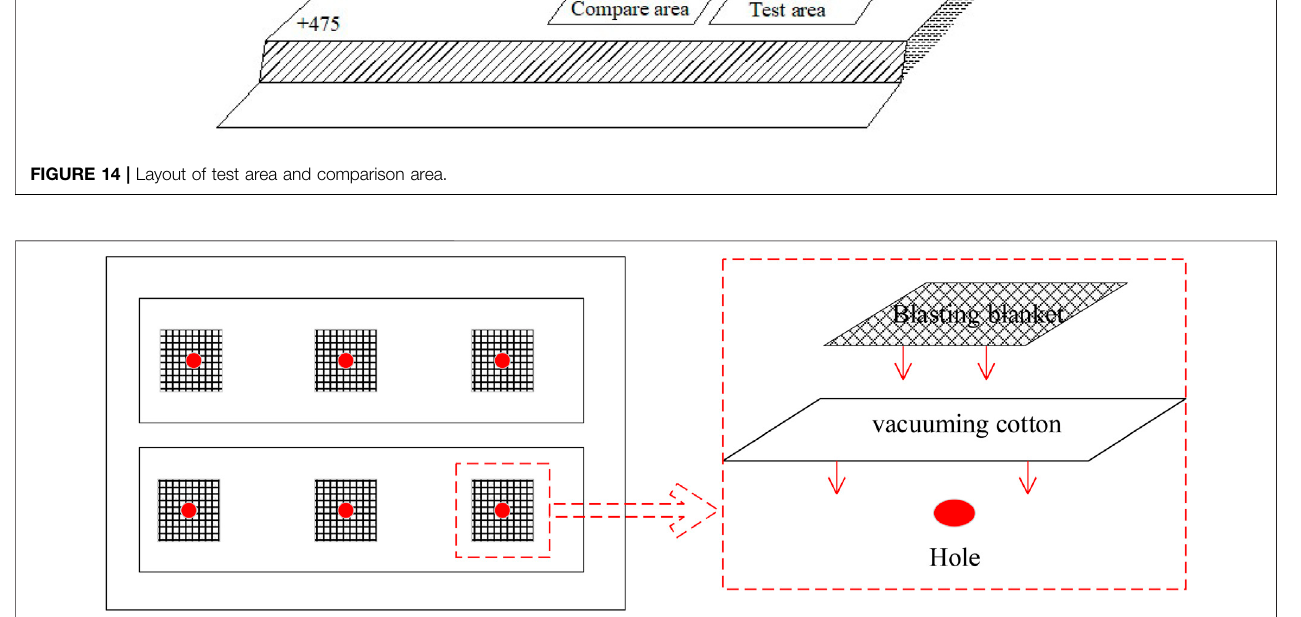
FIGURE 15 | Site test layout